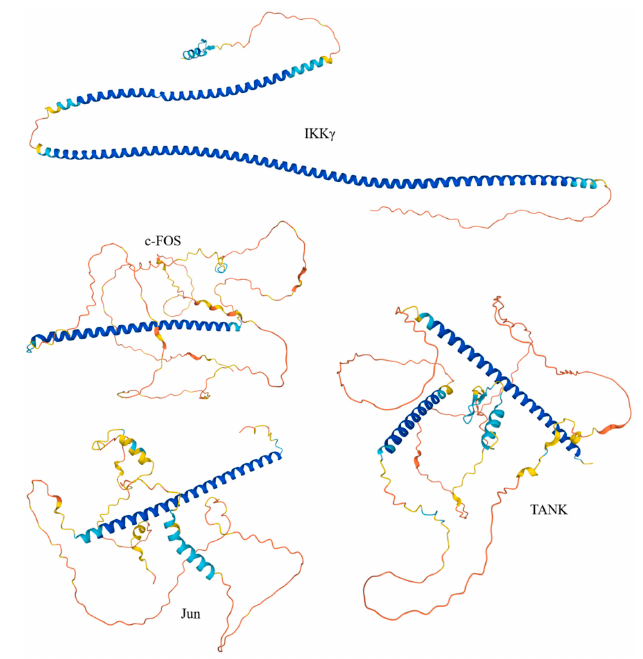
Figure 5. The 3D-structures modeled for human IKK γ , c-FOS, Jun, and TANK by AlphaFold [142] . Note the absence of the compact globular core in these proteins.